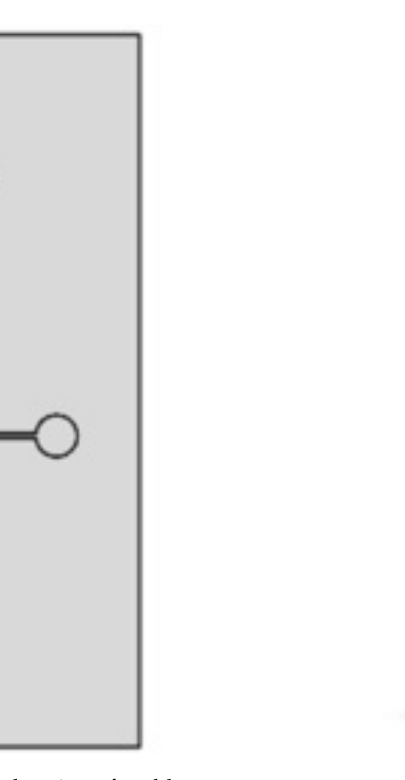
Figure 2. Design three-dimensional drawing of mold.